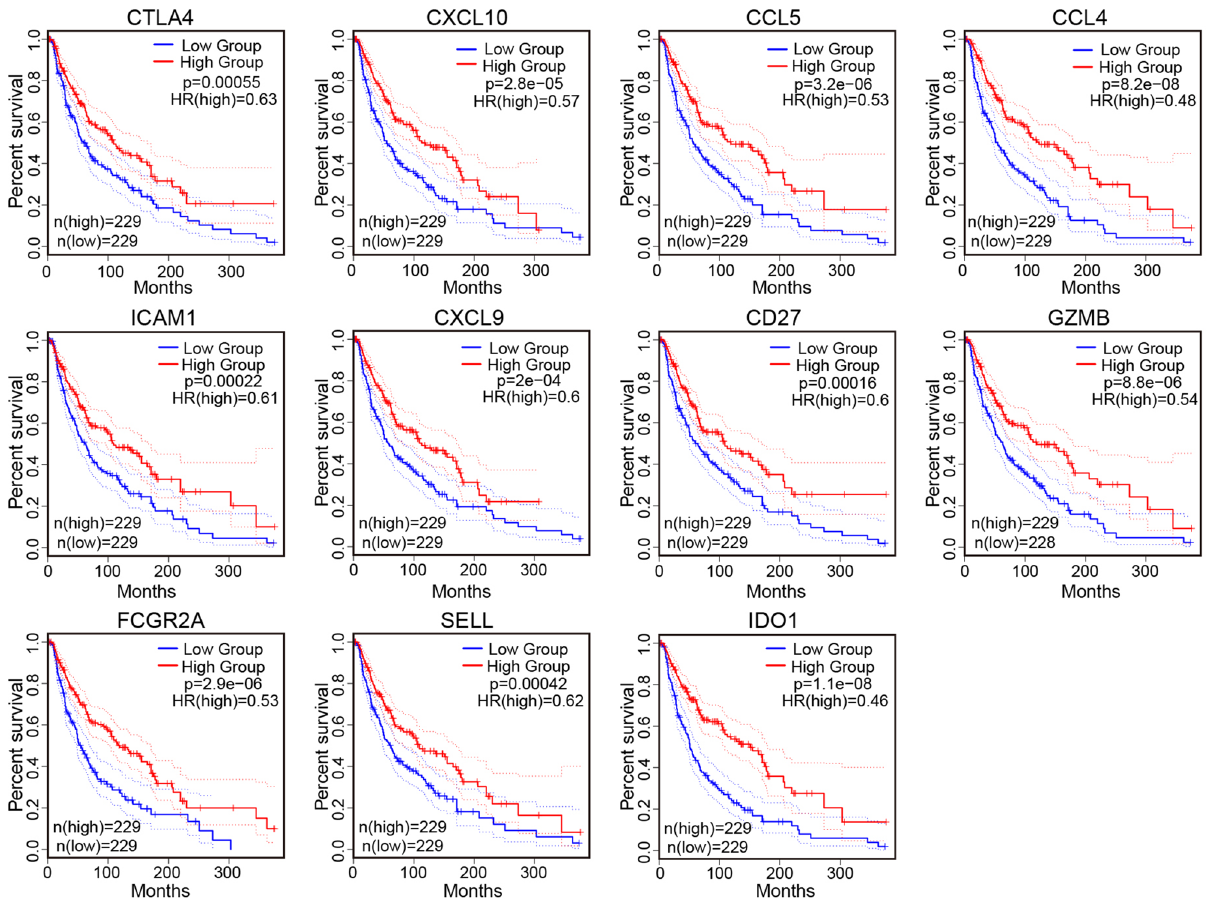
Figure 5. Prognostic value of hub genes. Kaplan–Meier survival curves comparing the relationship between high and low expression of hub genes in the GEPIA database and overall survival in SKCM patients, the red curve represents high expression levels, while the blue curve represents low expression levels. SKCM skin cutaneous